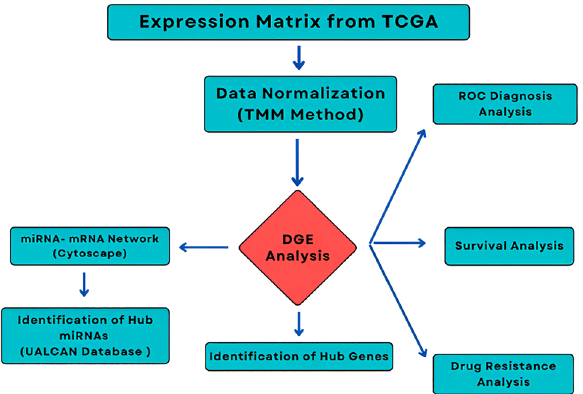
Figure 1. The flow chart of the present study for data collection, processing and